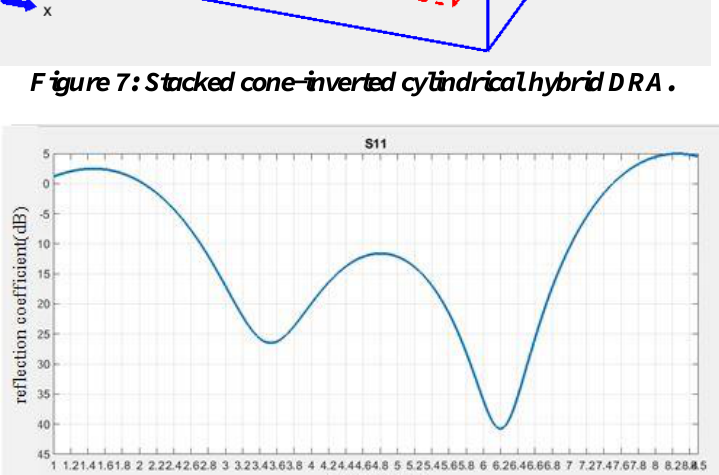
Figure 7: Stacked cone-inverted cylindrical hybrid DRA.